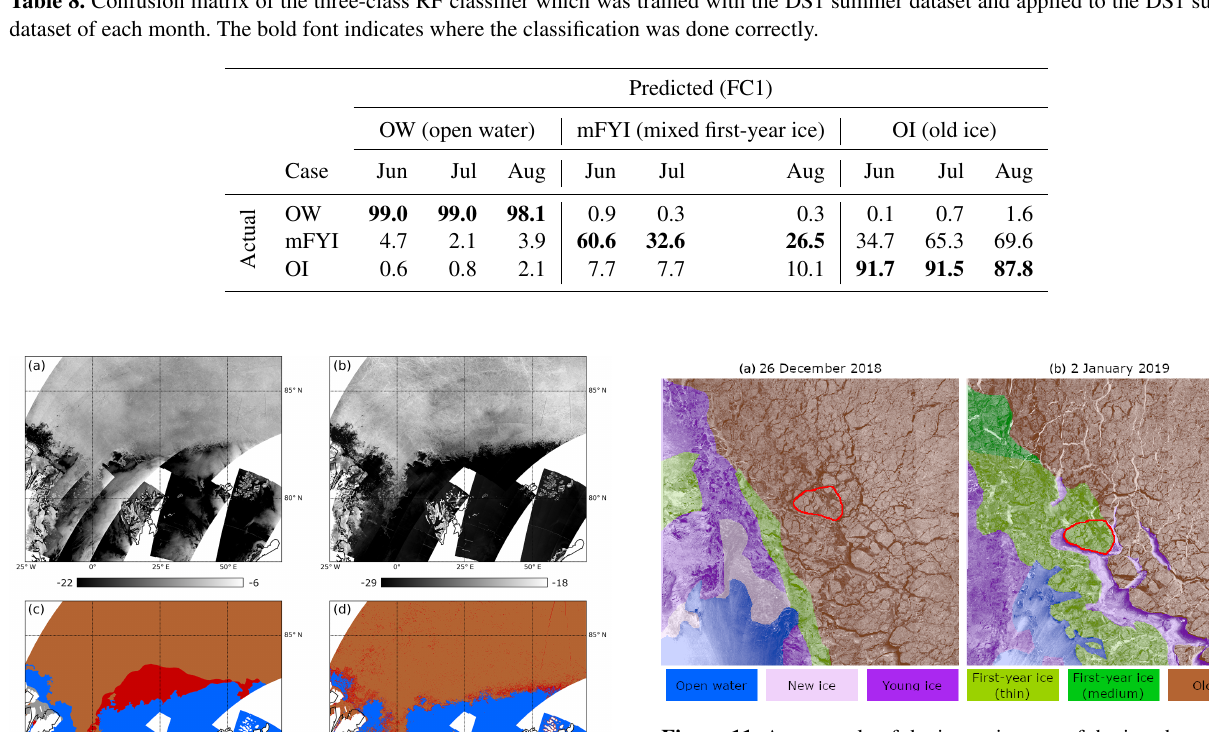
Figure 11. An example of the inconsistency of the ice charts. Note that the SoD labels and colours are of an original NIC ice chart, while those in Figs. 7 and 8 are of a simplified version as described in Sect. 2.2.1. The SoDs from the NIC ice charts on different dates (26 December 2018 and 2 January 2019) are superimposed on the Sentinel-1 backscattering image of the corresponding dates. The same ice floe (red outline) is classified differently in each ice chart (old ice in a and first-year ice in b ) despite the similarity in the SAR backscattering images. Source credits: U.S. National Ice Cen- ter (colours) and European Space Agency